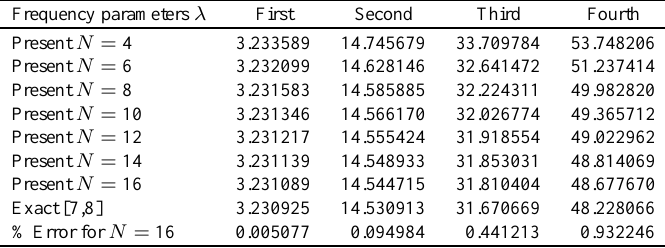
Table 3 Comparison offrequency parameters forrotating uniformTimoshenko